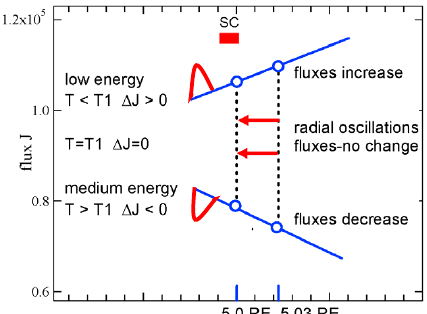
Figure 10. Scheme shows the distribution of fluxes versus radius (arbitrary numbers). Positive gradients ( (cid:49)κ/(cid:49)R) tend to amplify the particle response to a sudden compression while negative gra- dients lead to transient flux decreases. The flux perturbations are positive and negative (red curves) as a result of the earthward ad- vection of positive (upper blue line) and negative (bottom blue line) radial flux gradients.